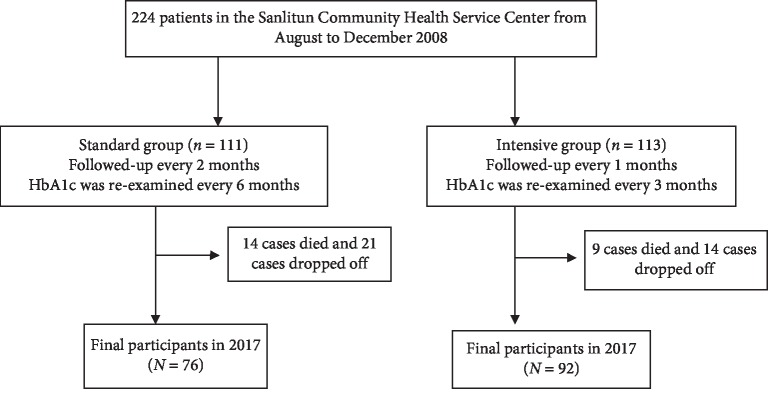
Flow chart showing the number of study participants.